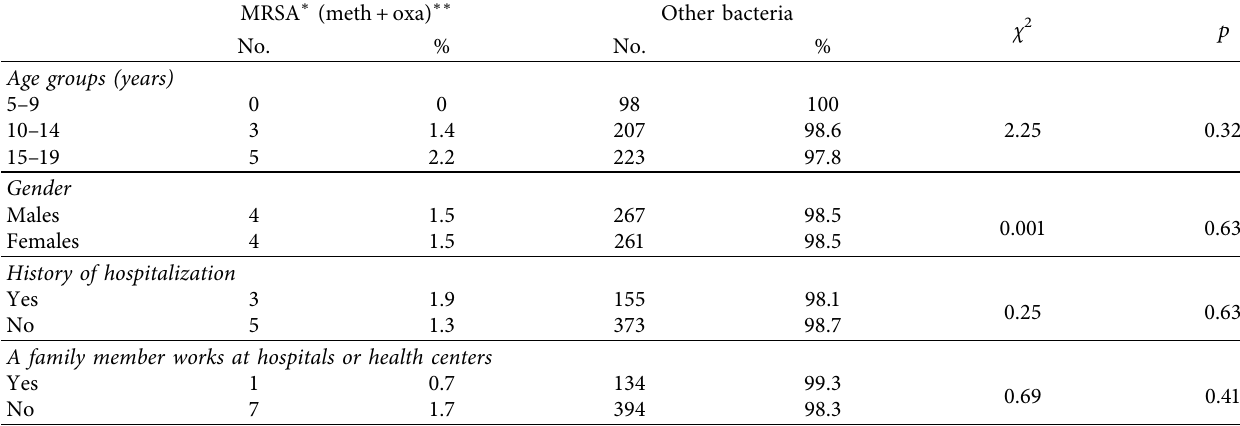
Table 3: Risk factors for nasal carriage of MRSA among schoolchildren in Sana’a city, Yemen. MRSA ∗ (meth+oxa) ∗∗ Other bacteria